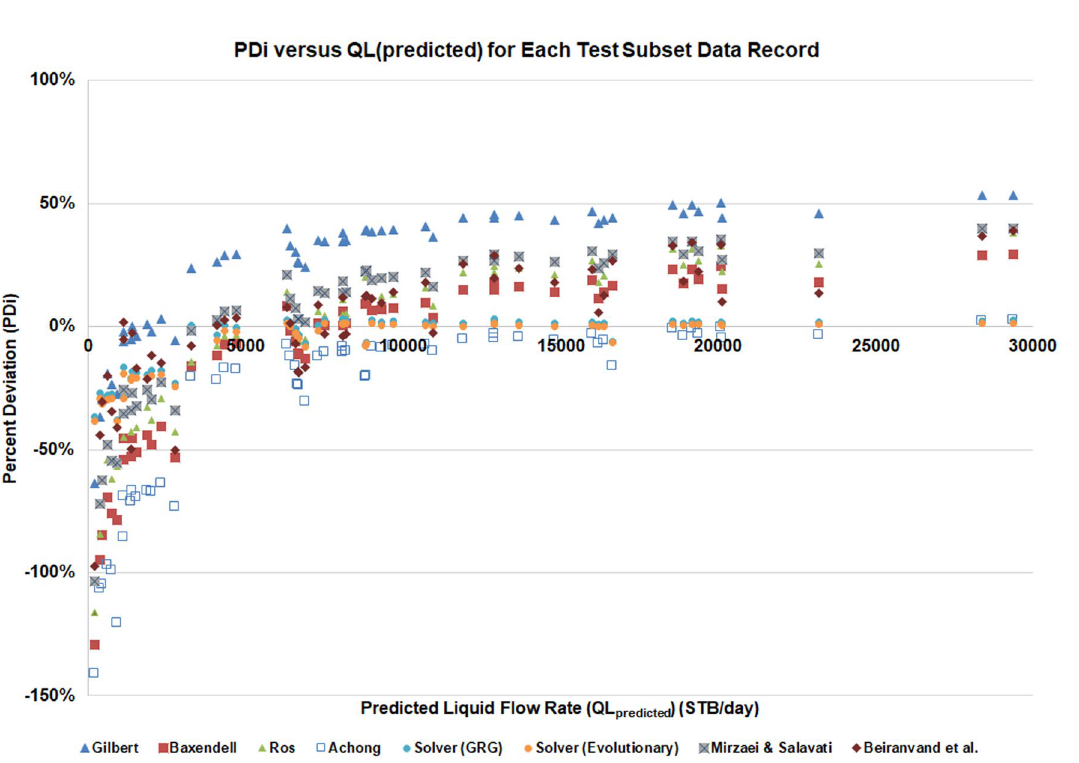
Fig. 10 Percent deviation (PD and Mirzaei-Paiaman and Salavati (2013) to the test data subset (55 i ) calculated by Eq. (11) for the data records). The Achong (1961) formula displays lower PDi values Reshadat oil field applying various coefficients to Eq. (19) for the than the other published formulas (reflecting lower prediction errors), published liquid flow-rate prediction formulas of Gilbert (1954), Bax- but these are higher than for our Eq. (8) (Fig. endell (1958), Ros (1960), Achong (1961), Beiranvand et al. (2012),